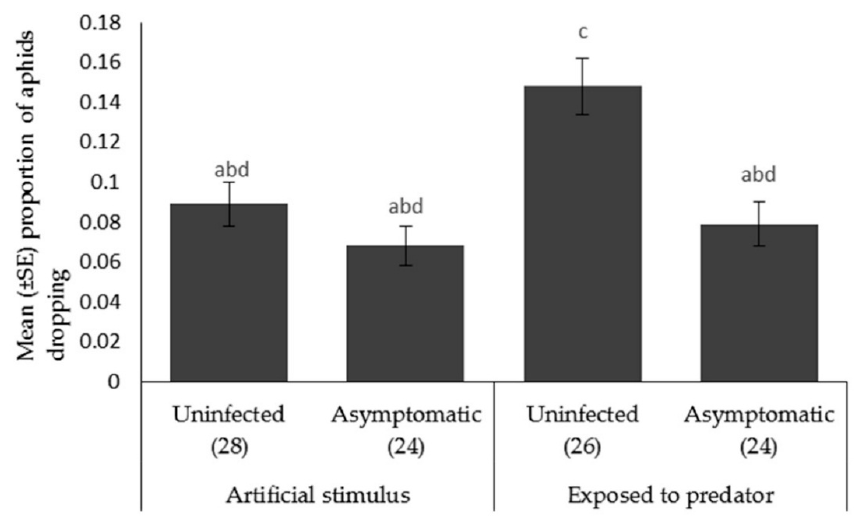
Figure 5. Mean ± SE proportion of Myzus persicae showing escape behavior (dropping) in response to